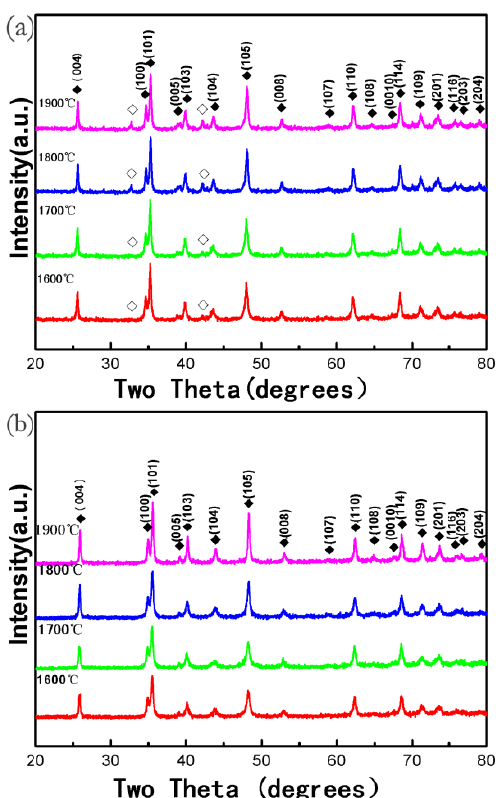
Figure 1. XRD patterns of the samples fabricated ( a ) W/B atomic ratios of 1/2 at 5.2 GPa and different temperatures (1600 – 1900 °C) for 15 min, ( b ) W/B atomic ratios of 1/2.2 at 5.2 GPa and different temperatures (1600 – 1900 °C) for 15 min. Solid rhombus represents tungsten diboride (WB 2 ). Hollow rhombus represents WB.